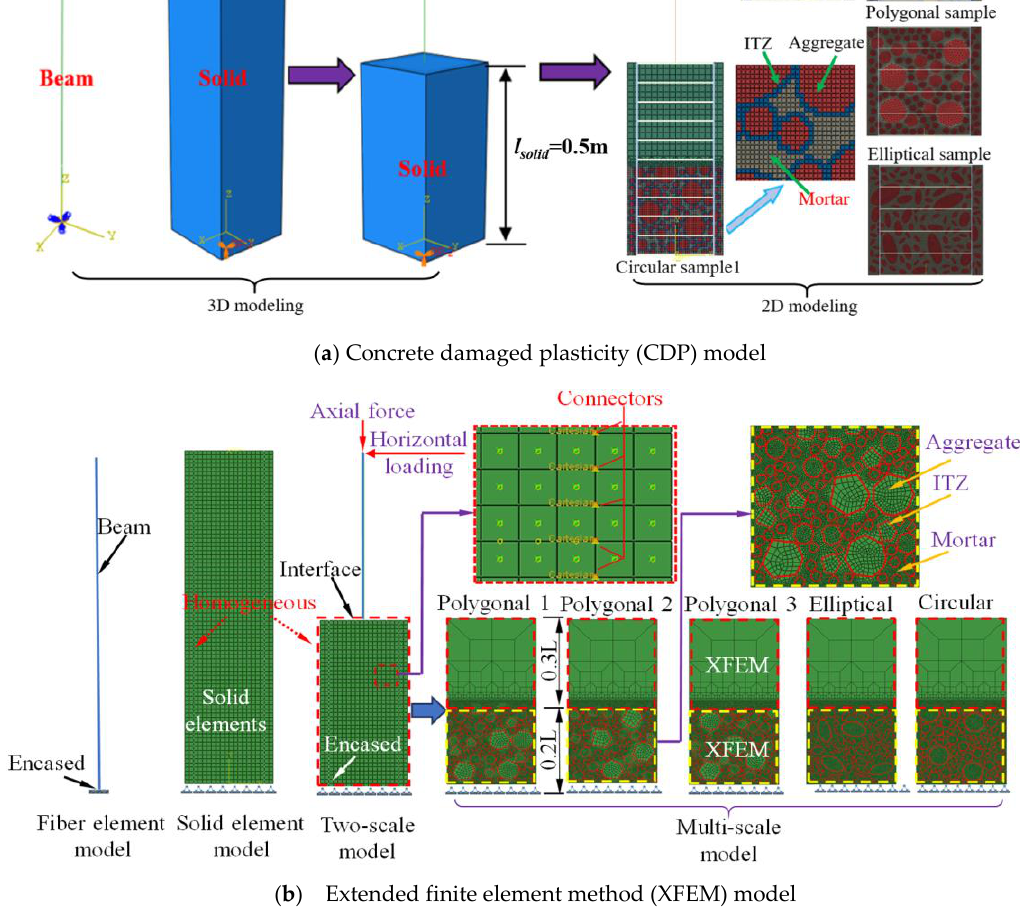
Figure 5. Multiscale modeling approaches.